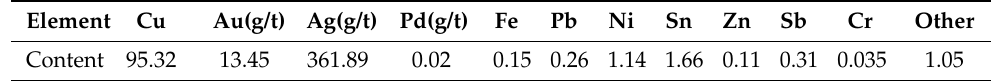
Table 2. Chemical composition of crude copper, wt.%. Element